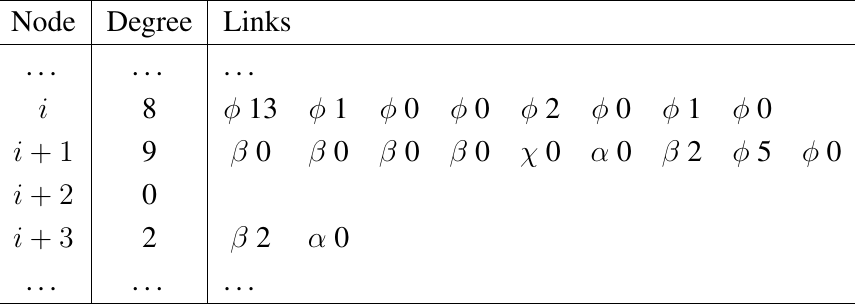
Table 3. Encoding of the adjacency list of Table